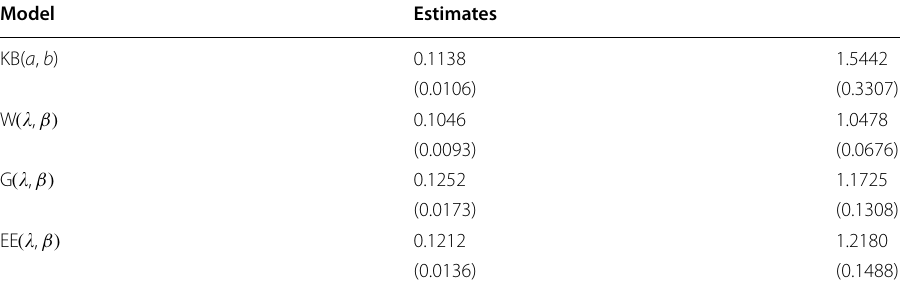
Table 3 MLEs and SEs for dataset 1 Model